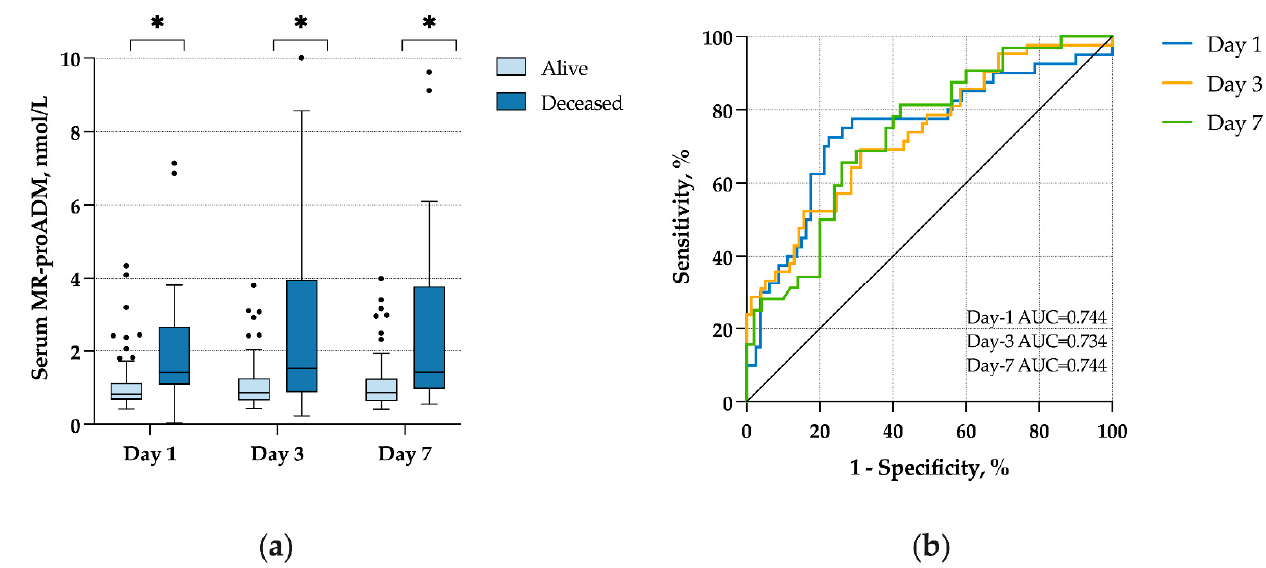
Figure 1. ( a ) MR-proADM concentrations according to day-60 survival; ( b ) ROC curves for day-60 survival of MR-proADM on days 1, 3, and 7. * p < 0.05. Survival curves according to this cut-point are presented in Figure 2. Survival curves according to the same cut-point for day-3 and day-7 MR-proADM are presented in Figure S2 and show a significant difference in day-60 mortality (log-rank test, p < 0.001 on day 3 and p = 0.002 on day 7). In a landmark analysis on day 3, the delta between day-3 and day- 1 MR-proADM was significantly associated with day-60 mortality (HR 1.20, 95% CI 1.01– 1.43, p = 0.04) (Table S1). On day 7, the delta between day-7 and day-1 MR-proADM con- centrations was not associated with day-60 mortality (HR 1.26, 95% CI 0.90–1.76, p = 0.16). Figure 2. Survival curves according to a cut-point of 1 nmol/L of MR-proADM on day 1.